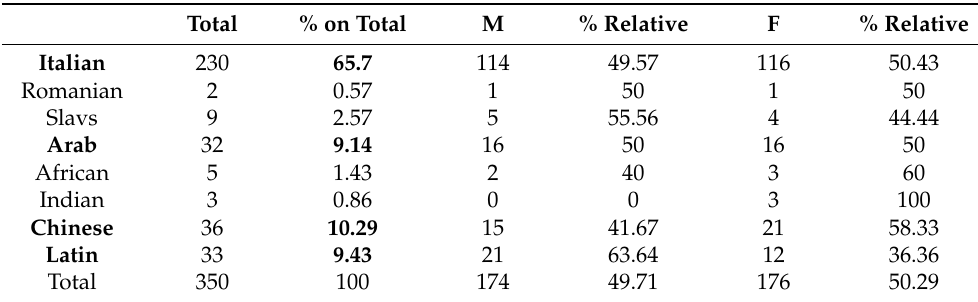
Table 1. Distribution of ethnicity and gender in the selected patient sample (in bold the most represented ethnic